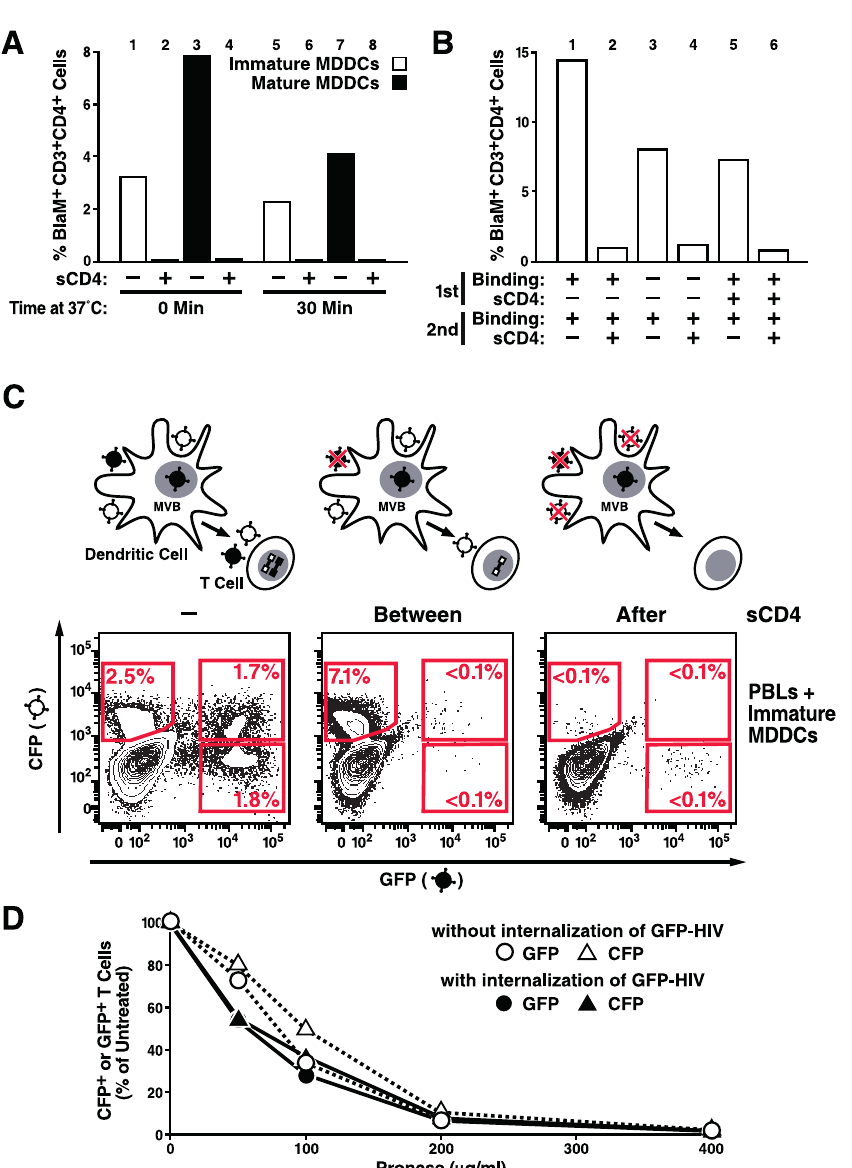
Figure 2. HIV-1 Virions Transmitted In Trans from MDDCs to T Cells Are Sensitive to sCD4 and Pronase (A) Immature and mature MDDCs were incubated at 4 8 C with NL4–3 virions containing BlaM-Vpr, washed, and incubated for 30 min at 37 8 C to allow virion internalization or held at 4 8 C. MDDCs were treated (or not) with sCD4 at 4 8 C to inactivate cell-surface virions. After extensive washes, loaded MDDCs were added to autologous PBLs to allow HIV-1 trans -infection of T cells. Fusion was measured with the virion-based fusion assay after gating on the CD3 þ CD4 þ cells. The histogram presents a representative experiment independently performed five times with similar results. (B) sCD4 treatment of MDDCs loaded with HIV-1 virions does not inhibit transfer of virions loaded after treatment. Two sets of HIV-1 virions containing BlaM-Vpr were successively bound to immature MDDCs and neutralized with sCD4. After incubation with autologous CD4 T cells, fusion to CD3 þ CD4 þ cells was assessed. (C) MDDCs were sequentially incubated with two reporter viruses (1 l g of p24 Gag each). GFP-HIV was bound and internalized, but CFP-HIV was bound only. Loaded MDDCs were incubated with autologous PBLs for 2 d. FACS plots show T cells analyzed for GFP and CFP expression when MDDCs were untreated or treated with sCD4 at 4 8 C between or after loading of the reporter viruses. (D) GFP-HIV and CFP-HIV were either successively bound to MDDCs or GFP-HIV was, in addition, internalized by MDDCs during a 30-min incubation at 37 8 C. MDDCs were then treated with increasing concentrations of pronase. Curves represent the number of T cells expressing CFP or GFP expressed as a percentage of the untreated samples. This graph presents a representative experiment with mature MDDCs that was independently performed three times with both immature and mature MDDCs.